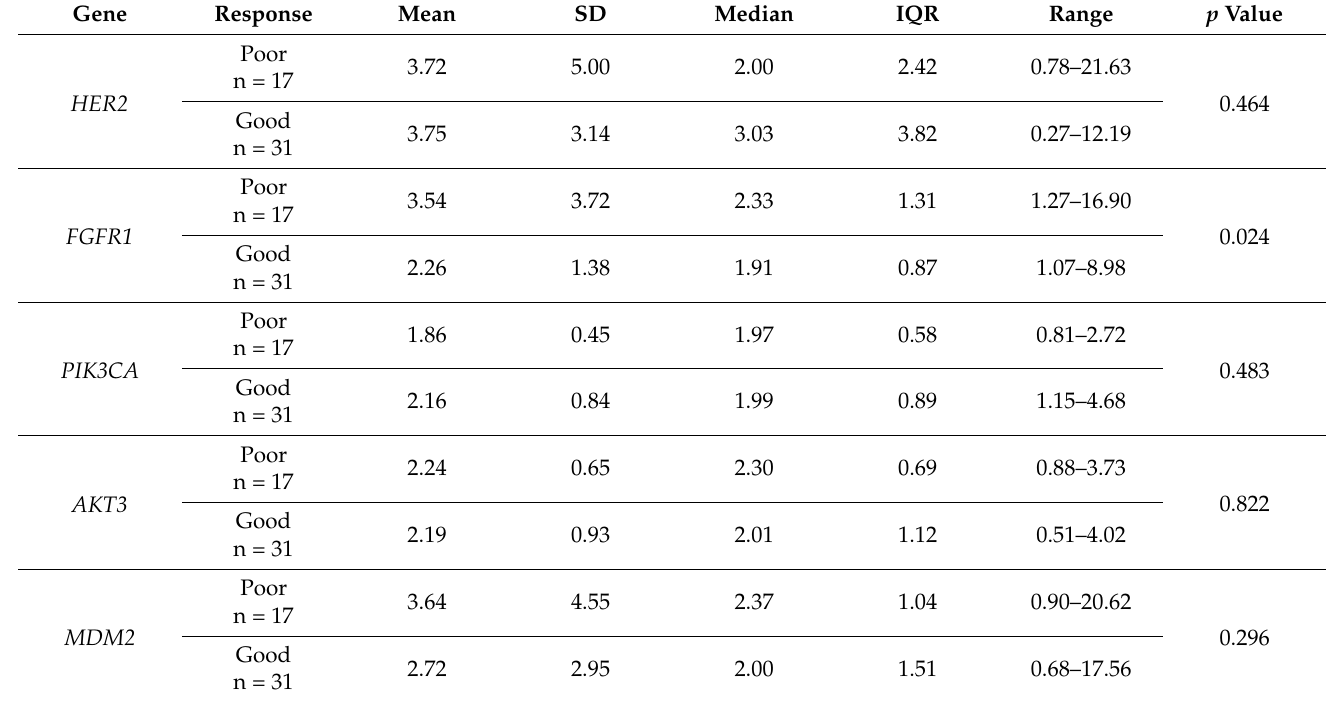
Table 3. Association between gene CNVs and anti-HER2 treatment response (Miller Payne 1-3 = poor response, Miller Payne 4-5 = good